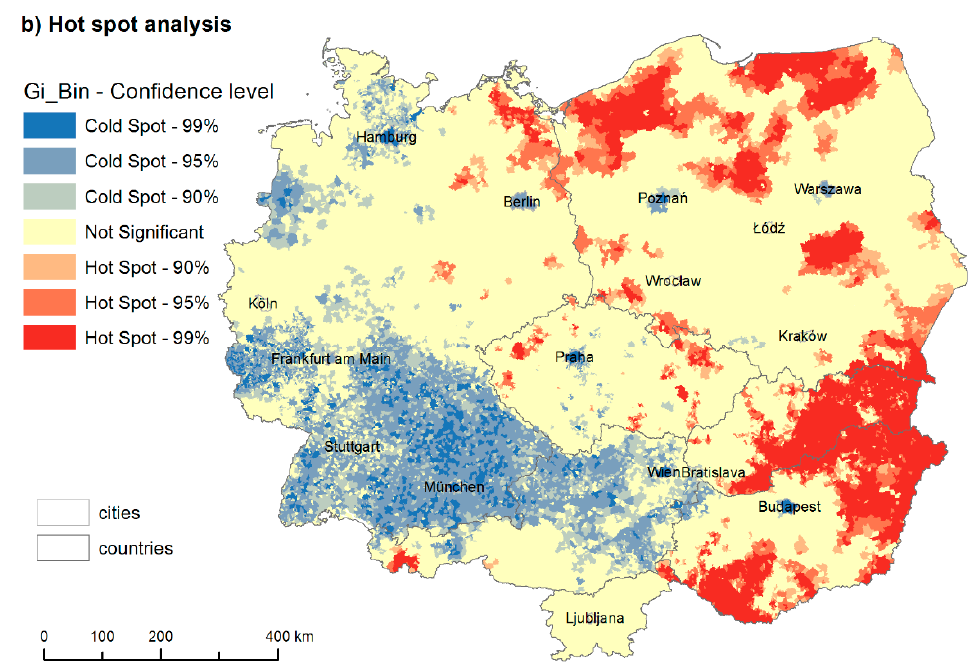
Figure 4. Choropleth map ( a ) and hot spot analysis ( b ) of unemployment in 2010 in municipalities in CER. Source: © EuroGeographics for the administrative boundaries, European Commission, Eurostat/GISCO.